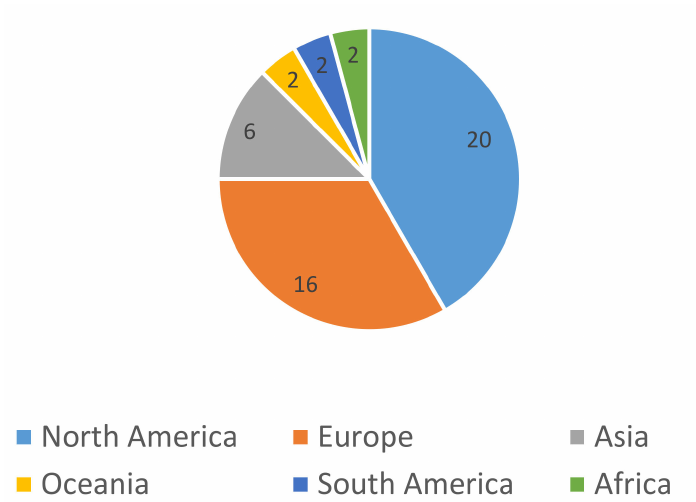
Figure 3. Geographic regions of data